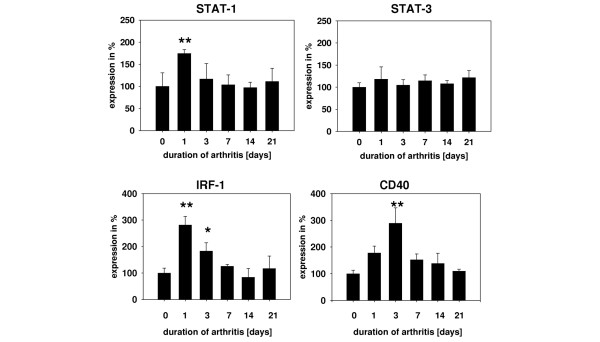
mRNA expression of STAT-1, STAT-3, interferon regulatory factor (IRF)-1 and CD40 in murine arthritic knee joints. Total RNA was isolated from joint capsules including the synovial tissue before (day 0) and after (day 1 to day 21) arthritis induction (n = 5 for day 0, 1, 3 and 7; n = 4 for day 14 and 21). After reverse transcription, mRNA expression of STAT-1, STAT-3, IRF-1 and CD40 was measured by real time PCR. The house keeping genes encoding β-actin (for STAT-1 and STAT-3) and GAPDH (for IRF-1 and CD40) were used for normalization of expression. Mean of day 0 expression was set at 100%. *P ≤ 0.05, **P ≤ 0.01 versus day 0.